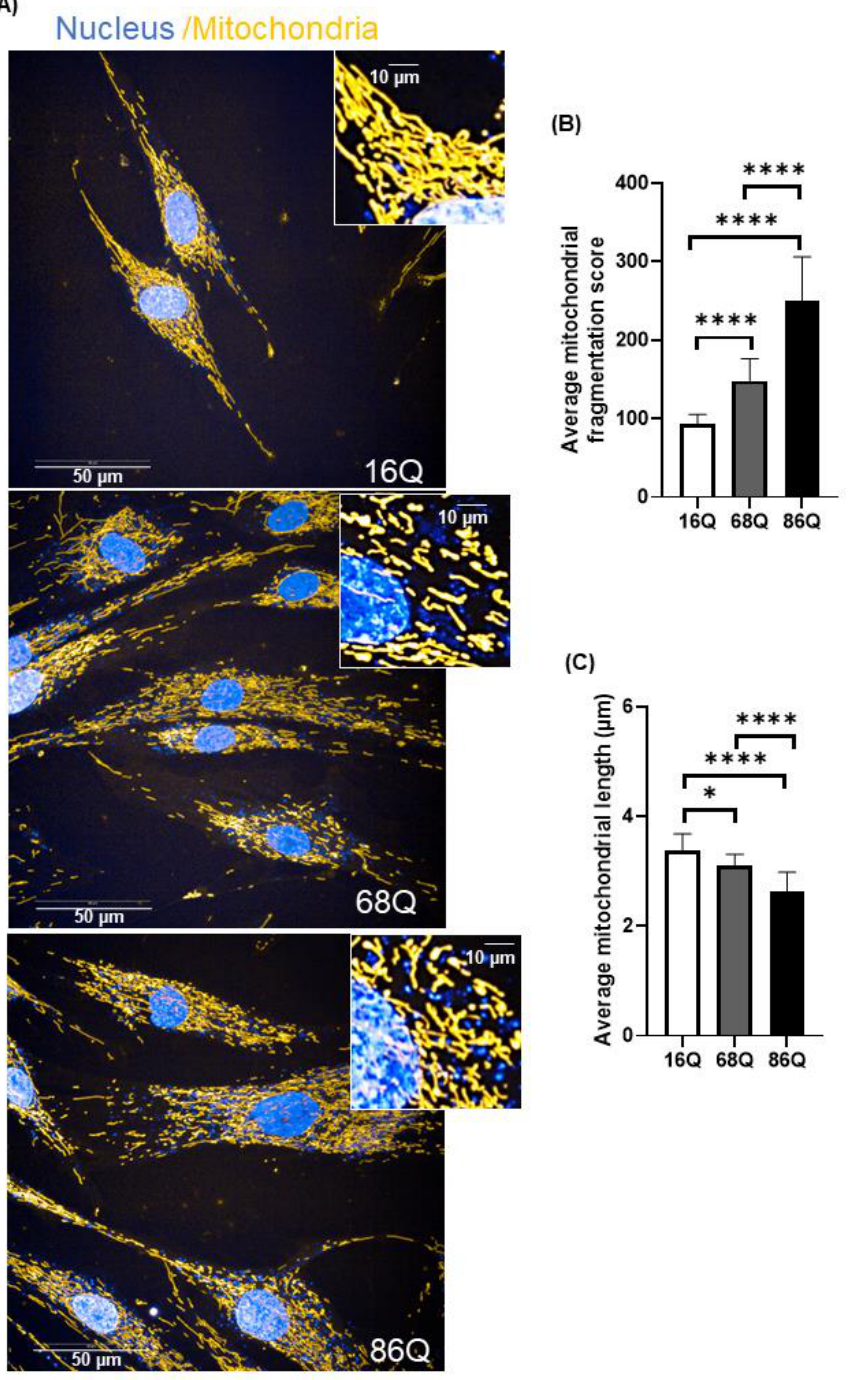
Figure 5. Increased mitochondrial fragmentation and reduced mitochondrial length in juvenile HD fibroblasts are not associated with reduced viability. ( A ) Representative HCS confocal fluorescent imaging of mitochondrial morphology in healthy (16Q) and juvenile HD (68Q, and 86Q) fibroblasts using 50 nM Mitotracker Red CMXRos. ( B , C ) Quantification of mitochondrial population and measurement of mitochondrial length in healthy and HD fibroblasts were performed using image analysis with the built in Harmony software. Two thousand cells were analyzed per condition. Data are presented as mean values ± SD and represent five independent experiments. Statistical analysis was performed using ANOVA test by GraphPad Prism 8.2.1 (* p < 0.05; ** p < 0.01, *** p < 0.001 **** p <